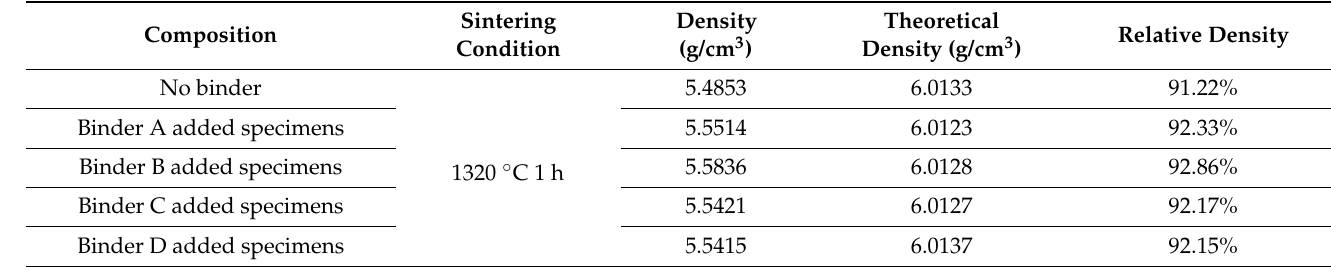
Table 5. Relative densities of the 0.1 wt.% Dy 2 O 3 –doped 0.98BaTiO 3 -0.02(Ba 0.5 Ca 0.5 ) SiO 3 specimens with different binders.